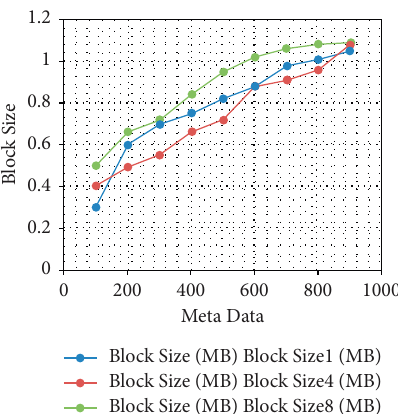
Figure 3: 1–10 GB metadata generation test. Table 1: Test data for metadata within 1 GB.